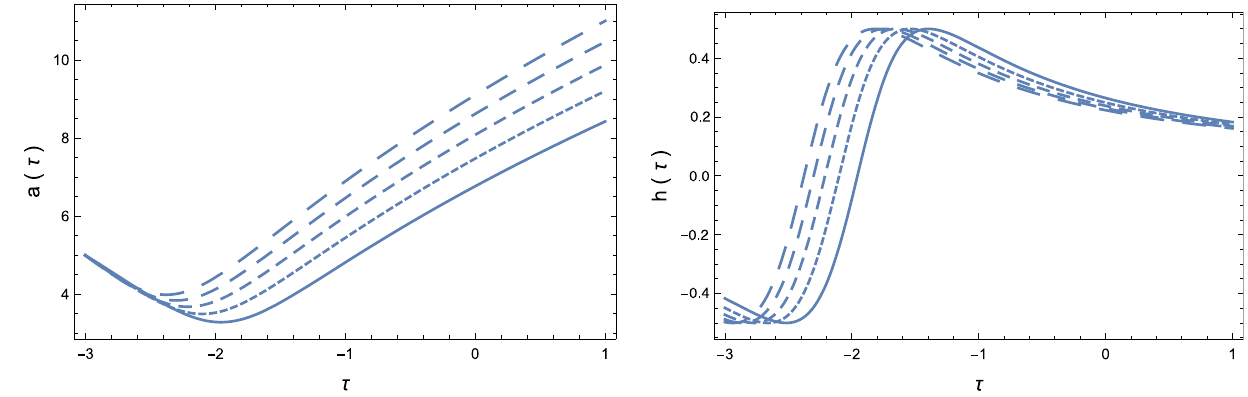
curve), A 3 = 6 × 10 − 44 (short dashed curve), A 3 = 7 × 10 − 44 (dashed curve), and A 3 = 8 × 10 − 44 (long dashed curve), respectively. The initial conditions used to numerically integrate Eqs. (71) and (72) are θ (τ ) = 2 × 10 44 , and with h 0 0 obtained from Eq. (96)